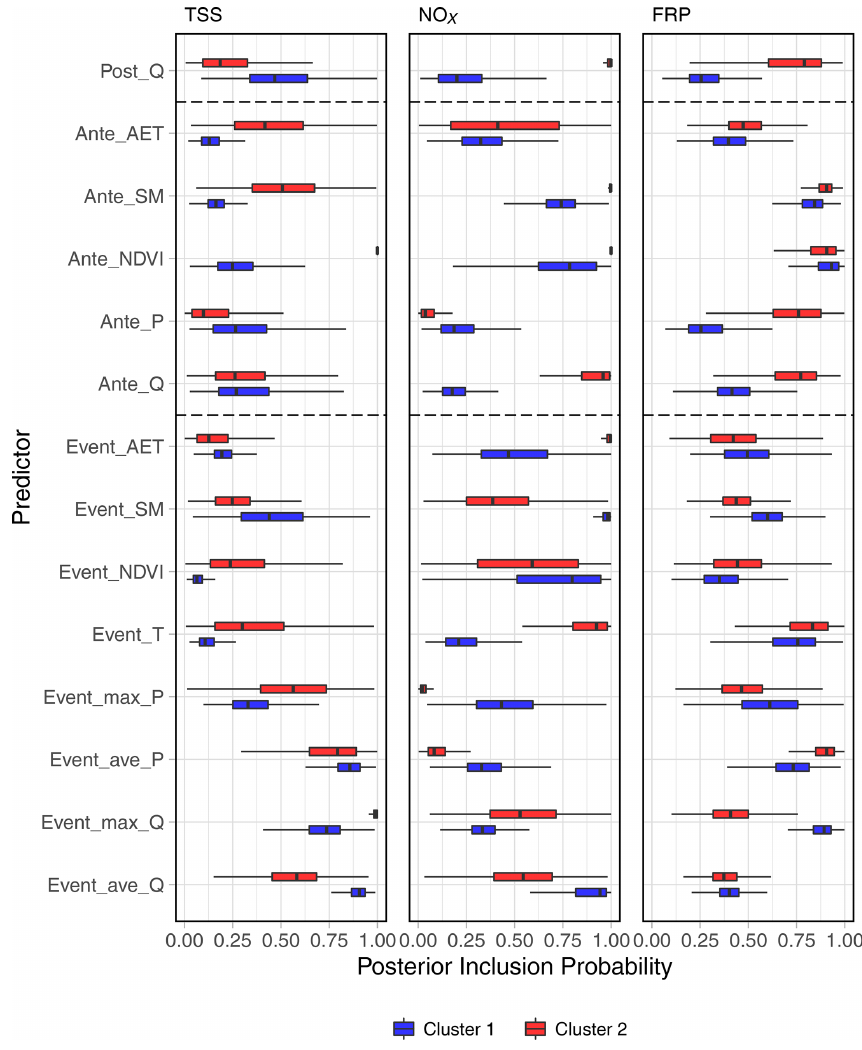
Figure 7. The comparisons of the distribution of posterior inclusion probabilities of the individual predictors derived from 1000 subsampled BMA runs. The boxes are the interquartile ranges (IQRs; 25th to 75th percentile), and the whiskers are the ranges between the 1.5 IQR of the lower quartile and 1.5 IQR of the higher quartile. The vertical bar is the median. Blue shows cluster 1 (wet) catchments, and red shows cluster 2 (dry) catchments. The definitions of the abbreviations of each predictor on y axes are given in Table